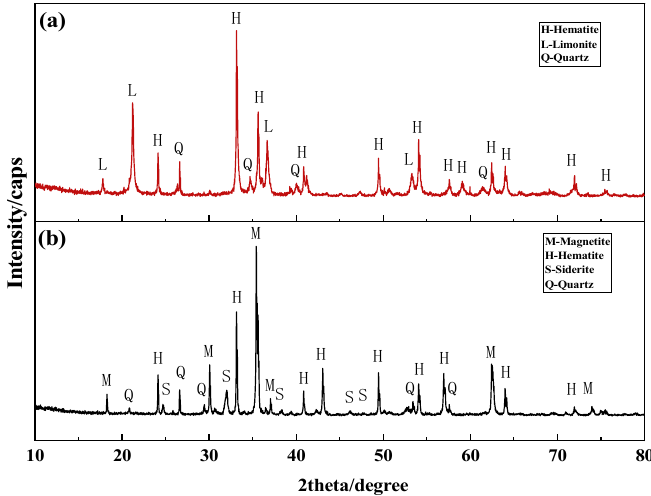
Figure 1. XRD pattern of Blended ore ( a ) and MCI ( b ). Figure 1. XRD pa tt ern of Blended ore ( a ) and MCI ( b ).